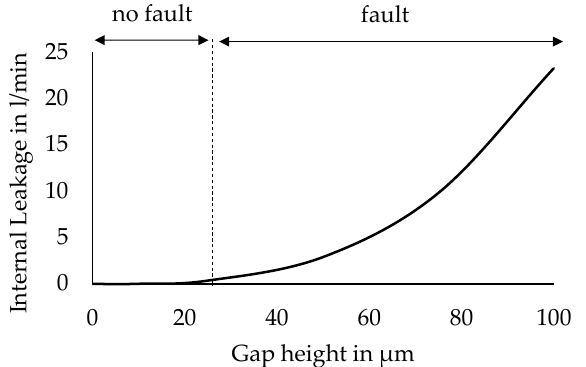
Figure 4. Example of non ‐ uniform class distribution over the range of fault ‐ indicating parameters.